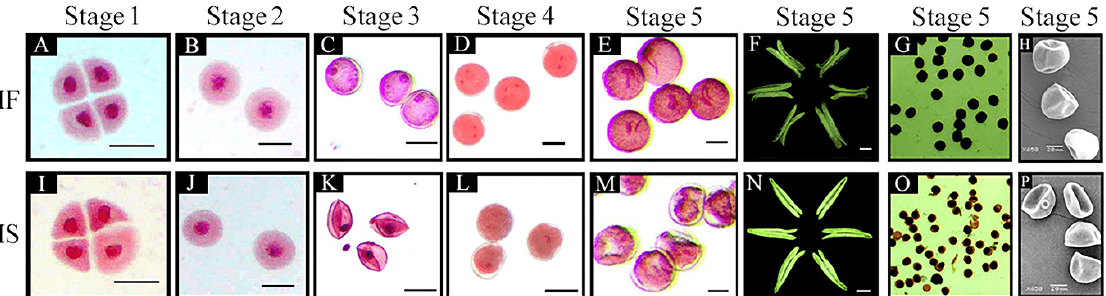
Figure 1. Phenotypes of anthers and microspores development in the male-sterile ( MS ) line and its near-isogenic male fertile ( MF ) line. Stage 1: tetrad stage ( A , I ); stage 2: early uninucleate stage ( B , J ); stage 3: late uninucleate stage ( C , K ); stage 4: binucleate stage ( D , L ); stage 5: trinucleate stage (